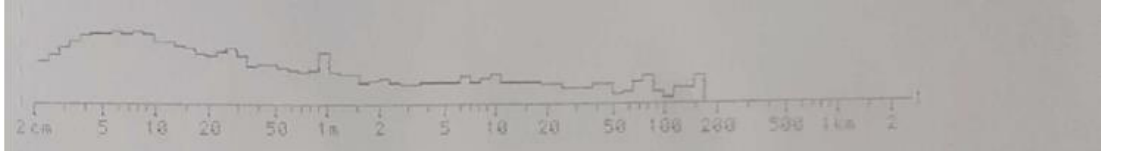
Figure 40. Presentation of spectral analysis results of purple cotton yarn in the user interface.